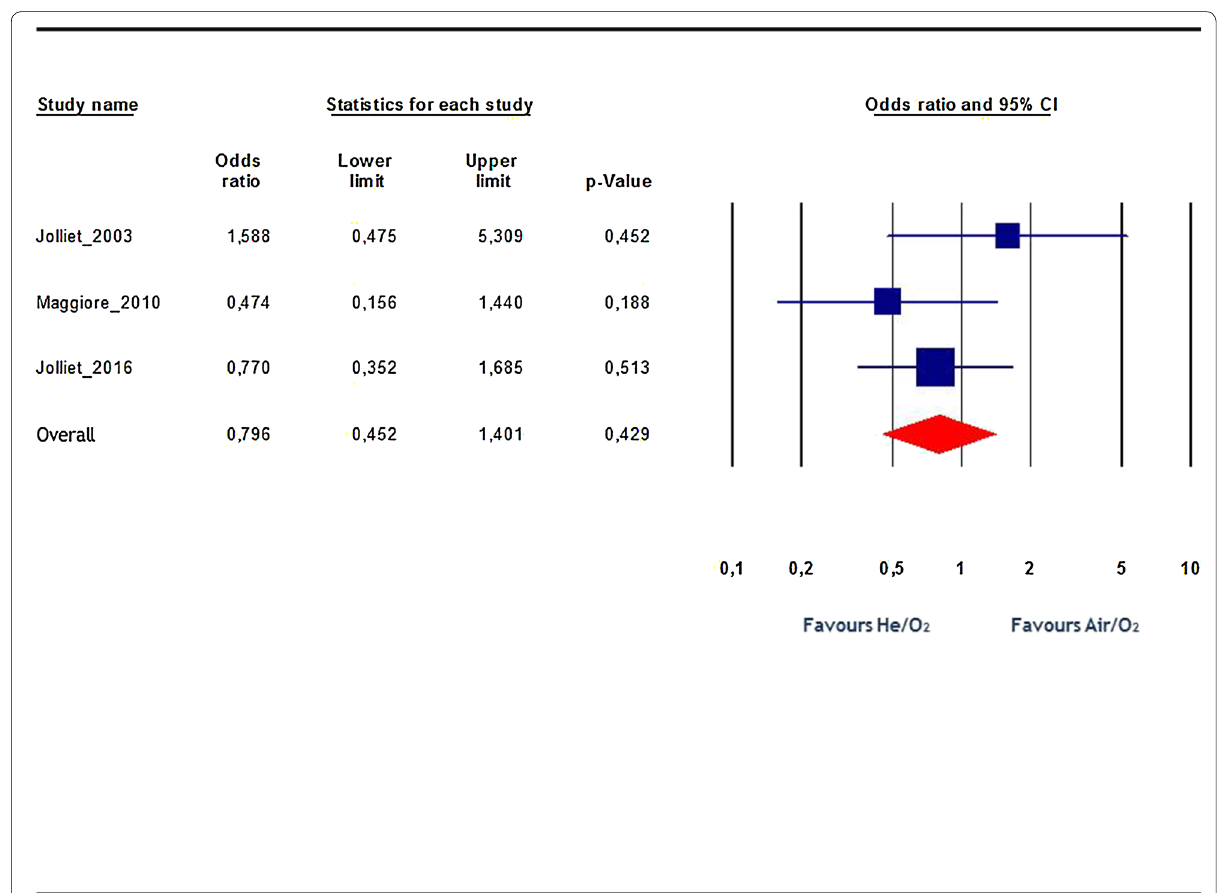
Fig. 3 Effects on ICU mortality rate. Blue squares represent odds ratios (ORs) in individual trials, while the red diamond represents the combined overall effects. I 2 test for heterogeneity: